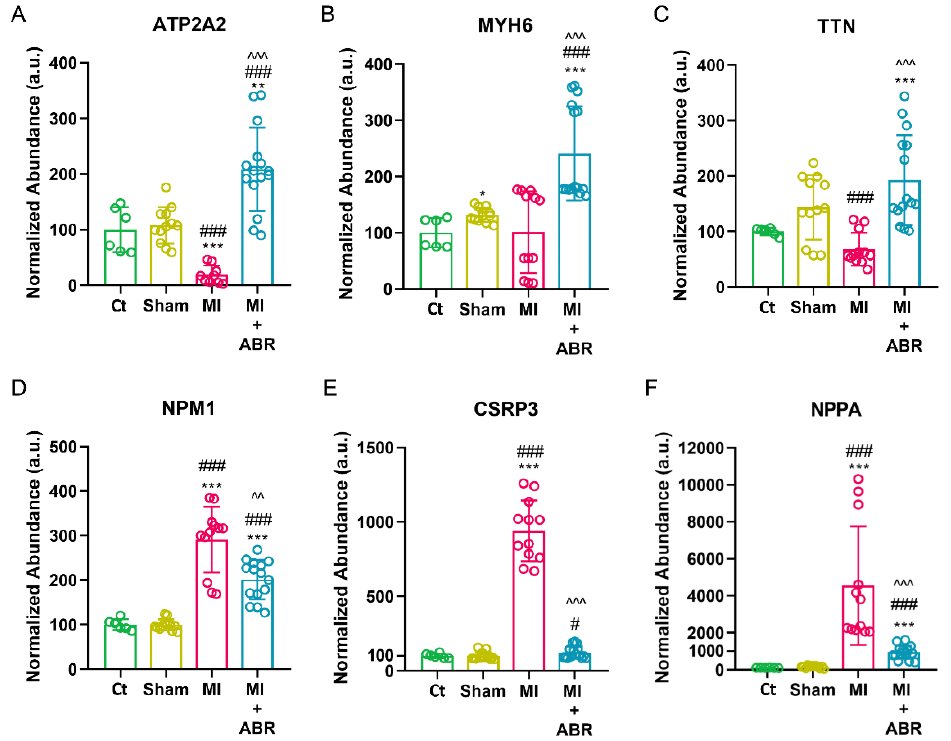
Figure 5. Impact of 3-day S100A9 inhibition on proteins involved in cardiac hypertrophy. LC MS/MS analysis showing the abundance of ATP2A2 ( A ), MYH6 ( B ), TTN ( C ), NPM1 ( D ), CSRP3 ( E ), and NPPA ( F ) in the experimental groups at day 7 post-MI. Data are presented as mean ± SD. Each sample was run in triplicate; * p < 0.05, ** p < 0.01, *** p < 0.001 vs. Ct; # p < 0.05, ### p < 0.001 vs. Sham; ^^ p < 0.01, ^^^ p < 0.001 vs. MI; p values were calculated using Student’s t test; ATP2A2, ATPase 2; MYH6, myosin-6; TTN, titin; NPM1, nucleophosmin; CSRP3, glycine-rich protein 3; NPPA, natriuretic peptide A.